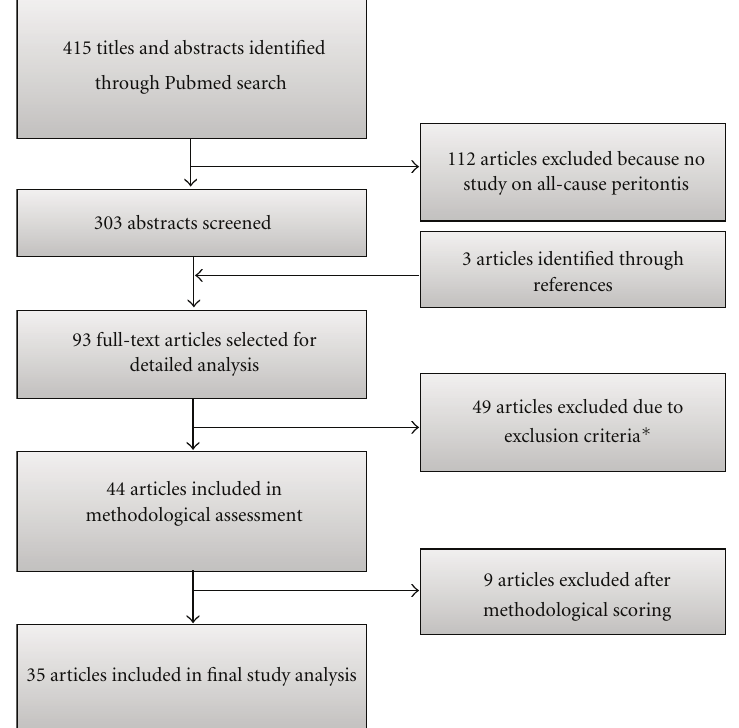
Figure 1: Process of identification of eligible studies. ∗ 16 studies: not on all-cause peritonitis; 21 studies: no patient risk factors, 6 studies: cohorts including children; 5 studies: cohorts < 40 patients; 1 study: single event